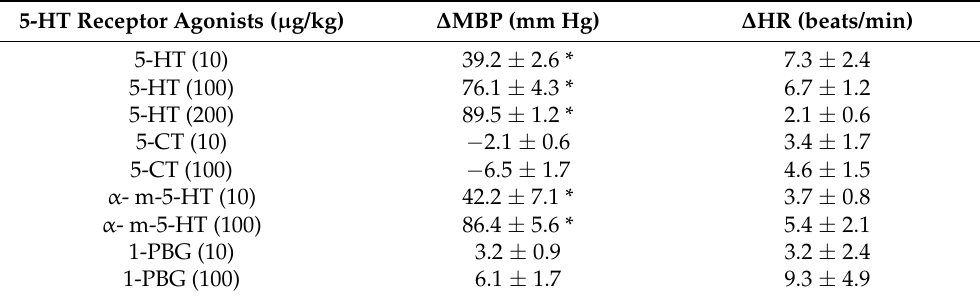
Table 1. Effect of 5-HT receptor agonists on haemodynamic variables in fluoxetine-treated dia- betic rats.